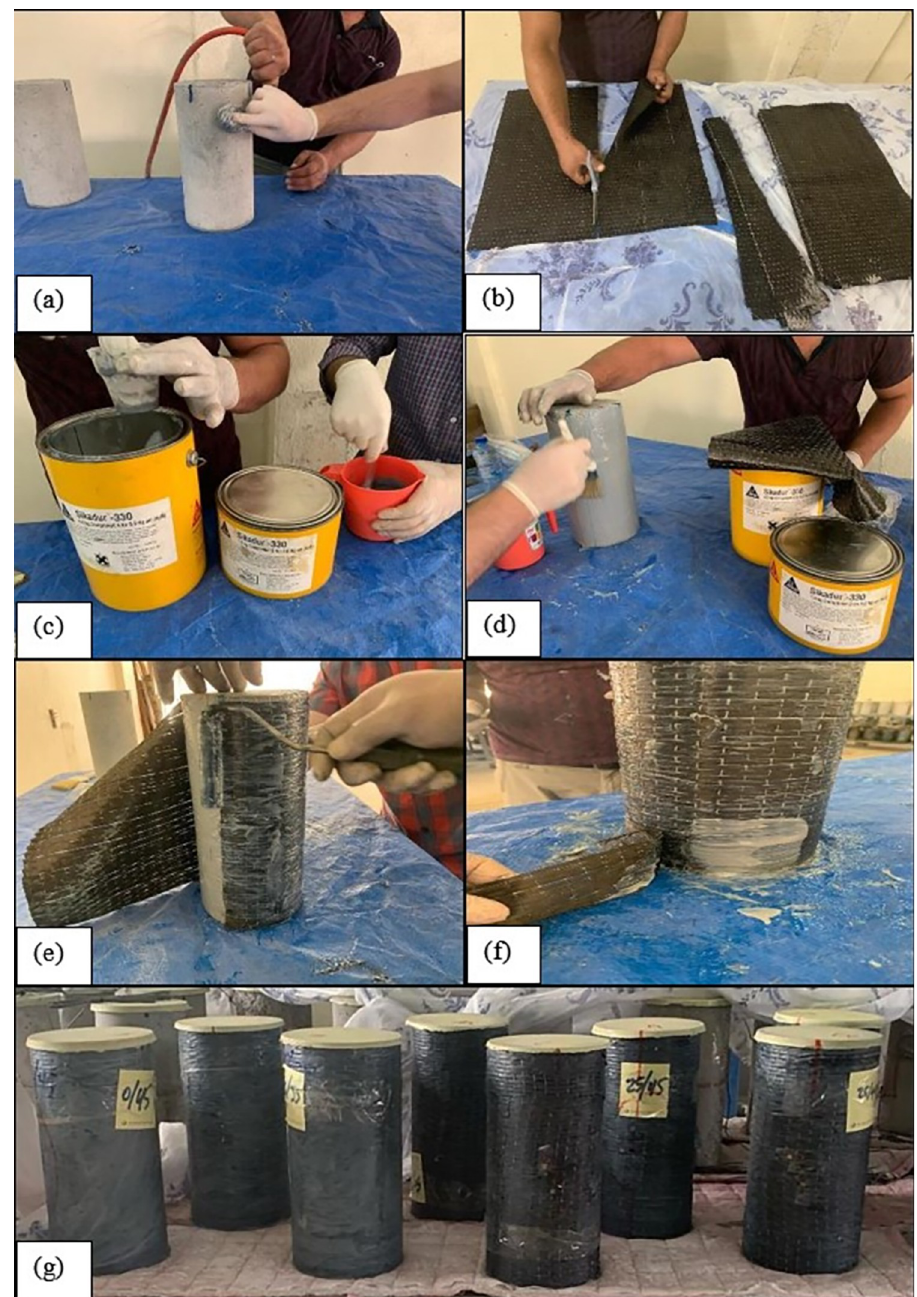
Fig 3. CFRP wrapping process: (a) cleaning; (b) cutting of laminate; (c) mixing epoxy resin; (d) coating cylinders; (e) wrapping CFRP laminate; (f) confinement of upper and lower ends; and (g) capping and